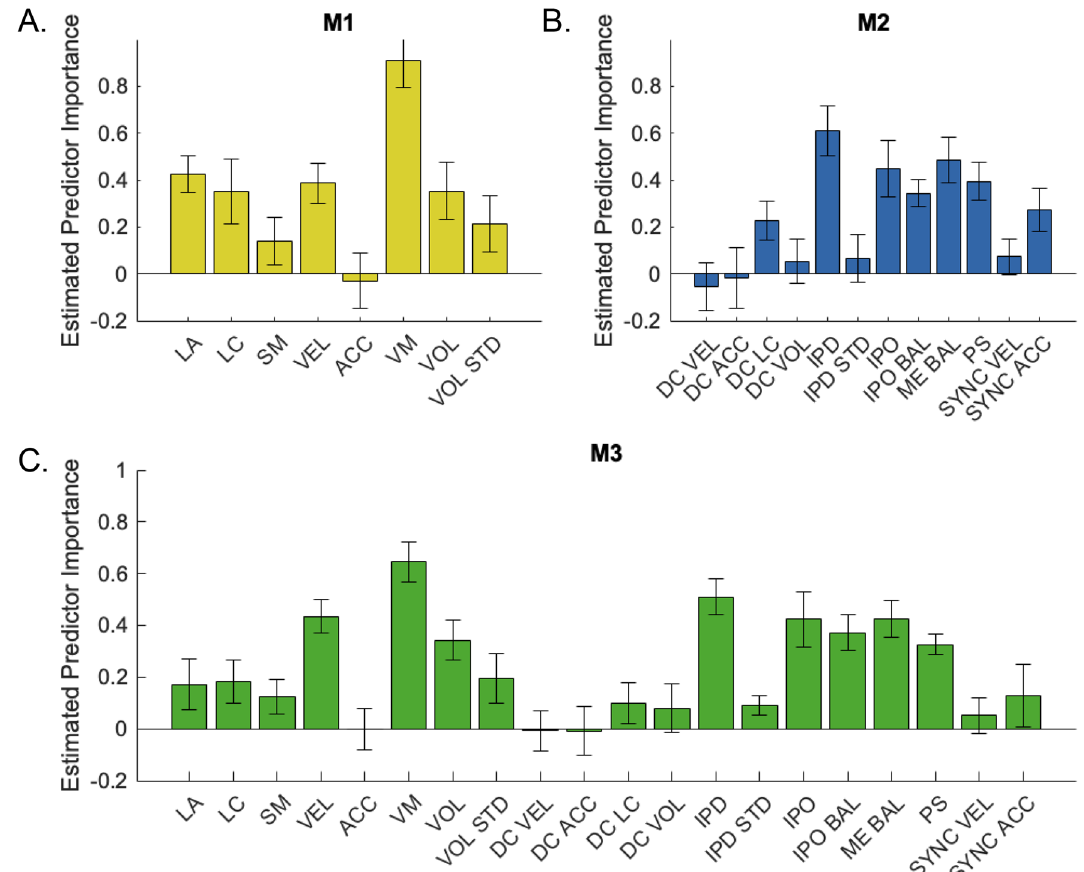
Figure 2. Estimated feature importance for emotion classification. ( A ) Model M1 = intrapersonal features as predictors (overall classification accuracy 56.75%). ( B ) Model M2 = interpersonal features as predictors (overall classification accuracy = 59.41%). ( C ) Model M3 = M1 + M2 combination model (overall classification accuracy of 69.54%). Bars and error bars show means and standard deviations of predictor importance for different validation samples. Chance level of emotion classification at 25%. LA limb angles, LC limb contraction, SM symmetry, VEL velocity, ACC acceleration, VM vertical movement, VOL volume, VOL STD volume standard deviation, DC VEL distance correlation velocity, DC ACC distance correlation acceleration, DC LC distance correlation limb contraction, DC VOL distance correlation volume, IPD interpersonal distance, IPD STD interpersonal distance standard deviation, IPO interpersonal orientation, IPO BAL interpersonal orientation balance, ME BAL motion energy balance, PS personal space, SYNC VEL synchronization velocity, SYNC ACC synchronization